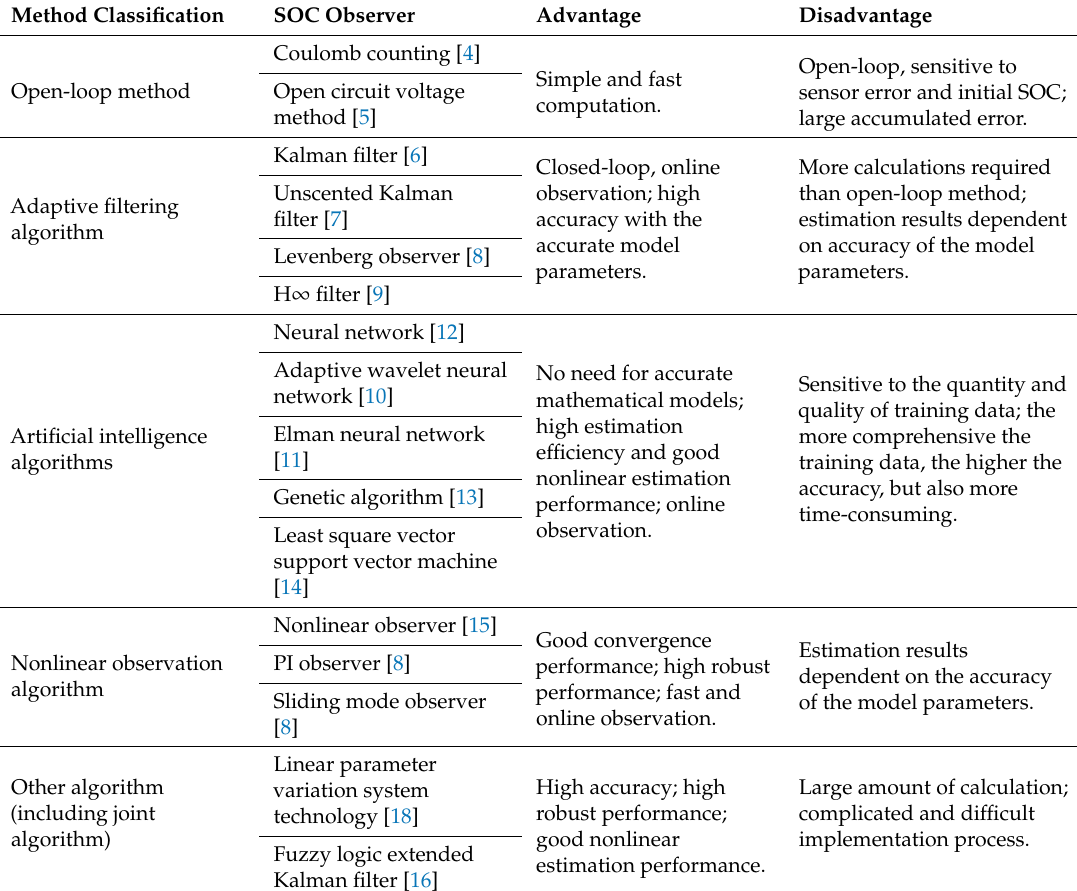
Table 1. Review of the state of charge (SOC) estimation